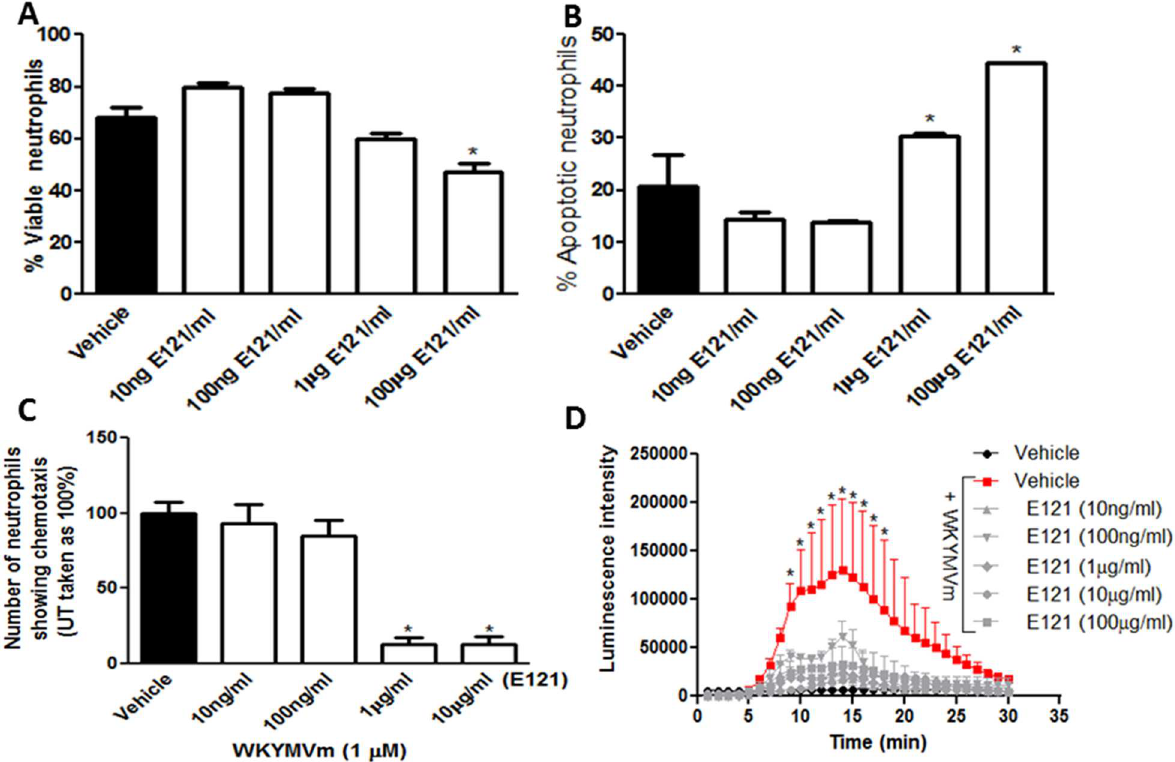
Fig 7. Effect of E121 on neutrophil apoptosis, chemotaxis, and superoxide release in vitro . Neutrophilswere isolatedfrom na ï ve mice and were treated with vehicle (solid bar) or variousconcentrations of E121 (open bars). PanelsA and B represent % viable and % apoptotic cells. Panel C represents neutrophilchemotaxis, determined using the under agaroseassay, towards WKYMVm (1 μ M) for vehicletreated (solid bar) or E121 treated (open bars) neutrophils. Panel D: superoxide releasedfrom neutrophilswas determined by recordingchemiluminescenceemanating from oxidationof luminolsubstrate as describedin Methods. Neutrophilswere treated with vehicleonly (solid circles), or 10 μ M WKYMVm plus vehicle(solid squares) or variousconcentrations of E121 (gray lines). Histobars represent means ± SEMs for 3 independentexperiments conducted with cells isolated from 3 mice in each group. Asterisks denote significantdifference from vehiclegroup, with p <